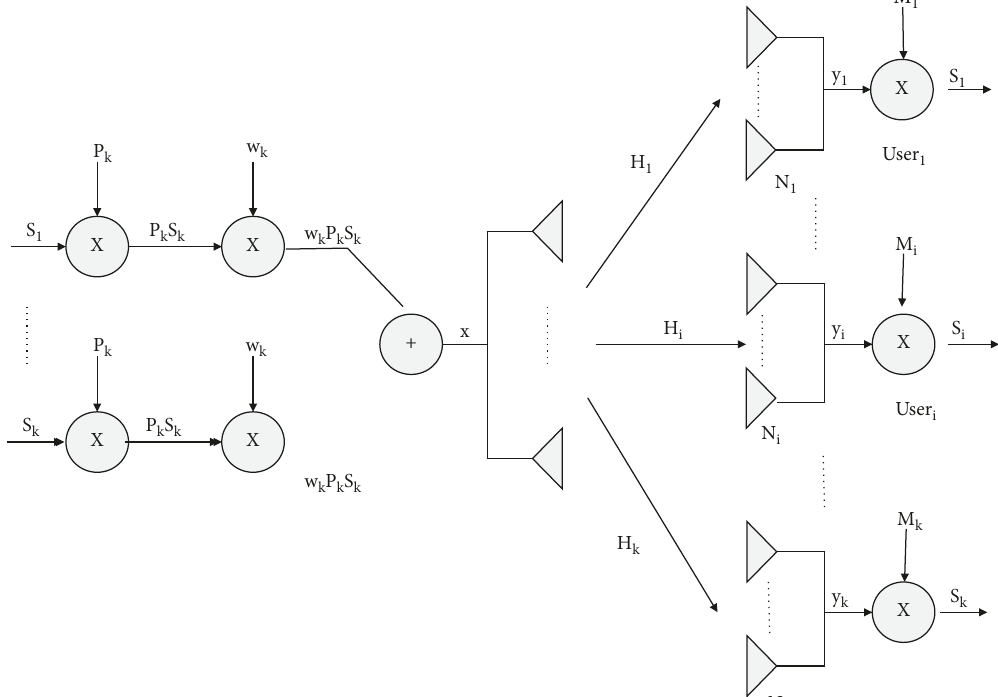
Figure 3: Multiuser MIMO system model diagram (including power allocation, precoding, and decoding process).